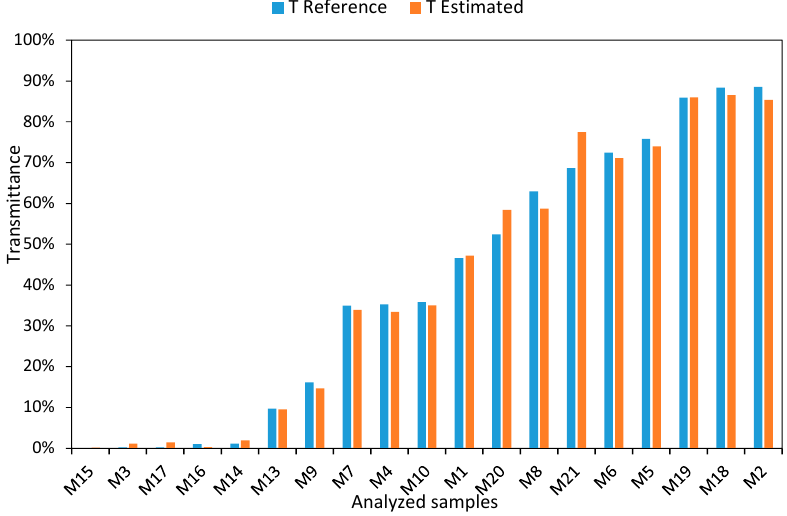
Figure 10. Comparison of calibration equations for 470 nm wavelength and brightness level 40.